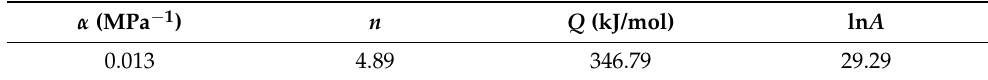
Table 2. Values of material constants at ε = 0.15.